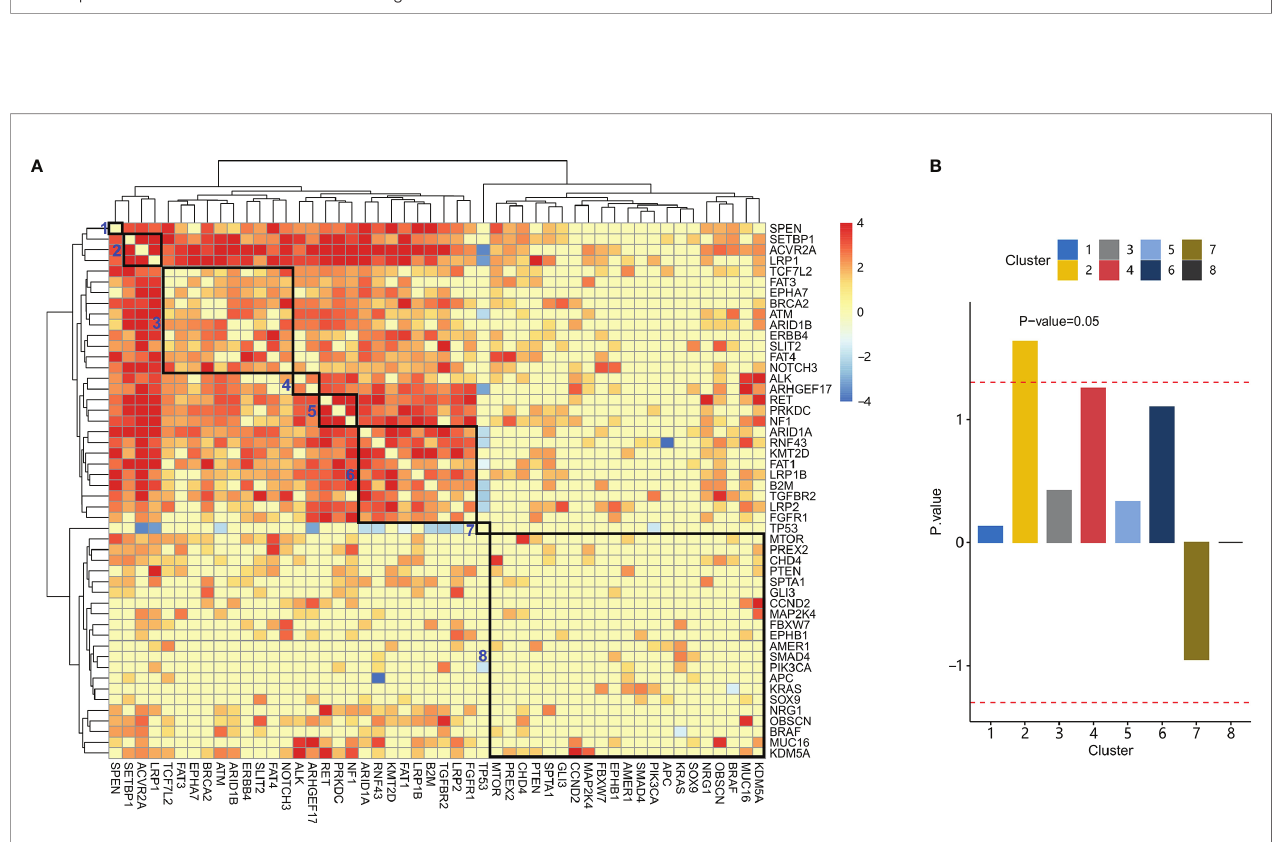
FIGURE 2 | Genomic mutations in advance CRC and their association with clinical characteristics. The top bar plot indicates the tumor mutational burden of each sample. The left bar plot indicates the frequency sum of mutations in each gene. The middle heatmap indicates the mutations of each gene in each sample. The right heatmap indicates the association between each gene and clinical character.